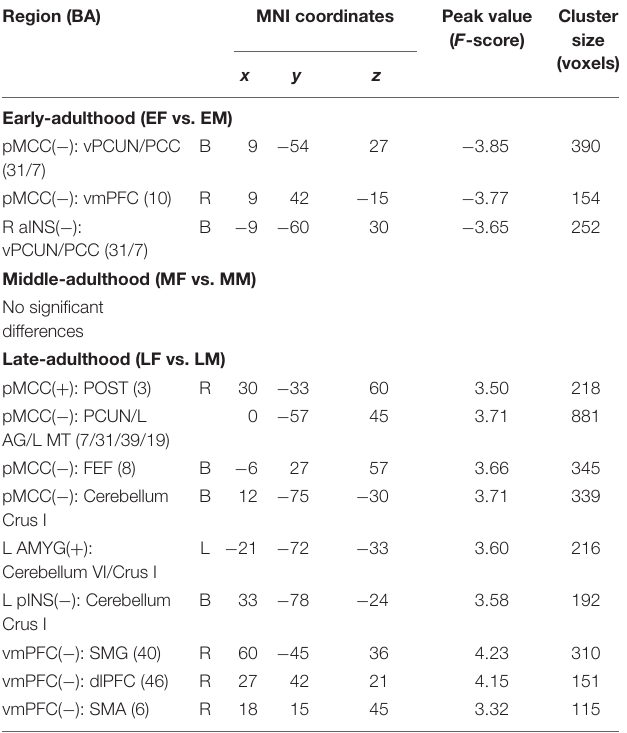
TABLE 1 | Regions showing the gender differences in different stages of adulthood. Region (BA) MNI coordinates Peak value